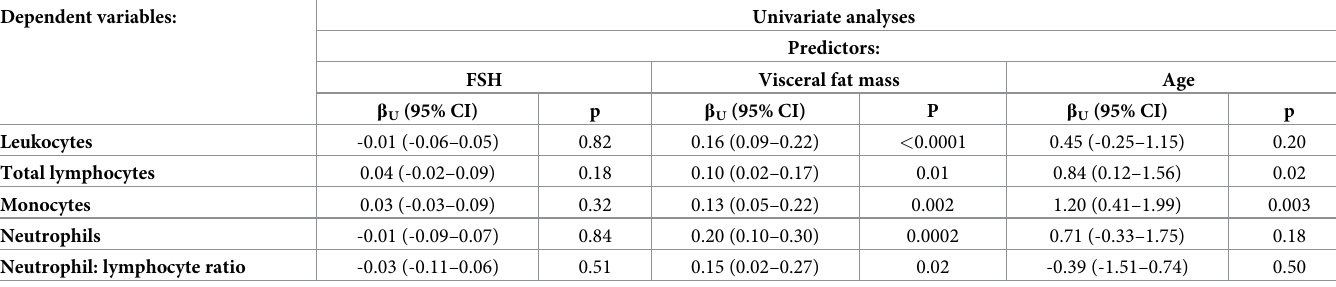
Table 2. Univariate regression analyses of predictors of white blood cell